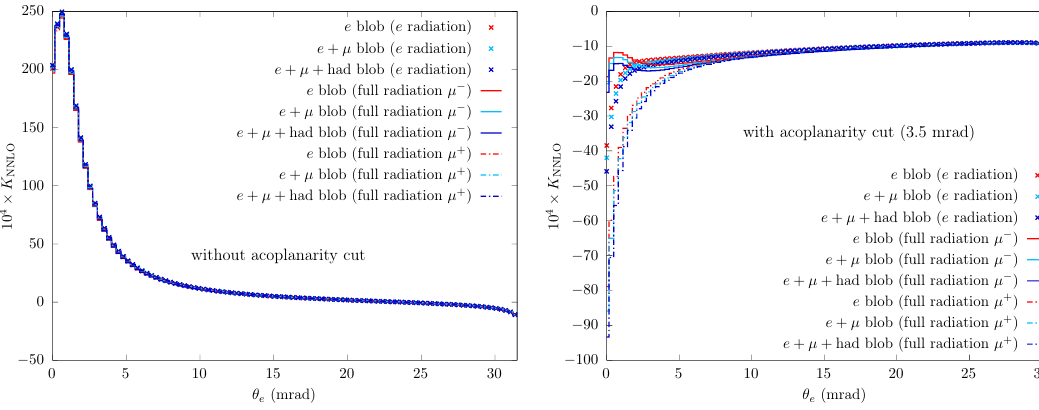
Figure 13. Left: differential K NNLO factor on θ e distribution, including the complete set of NNLO virtual leptonic pair corrections. Right: the same observable including the acoplanarity cut.